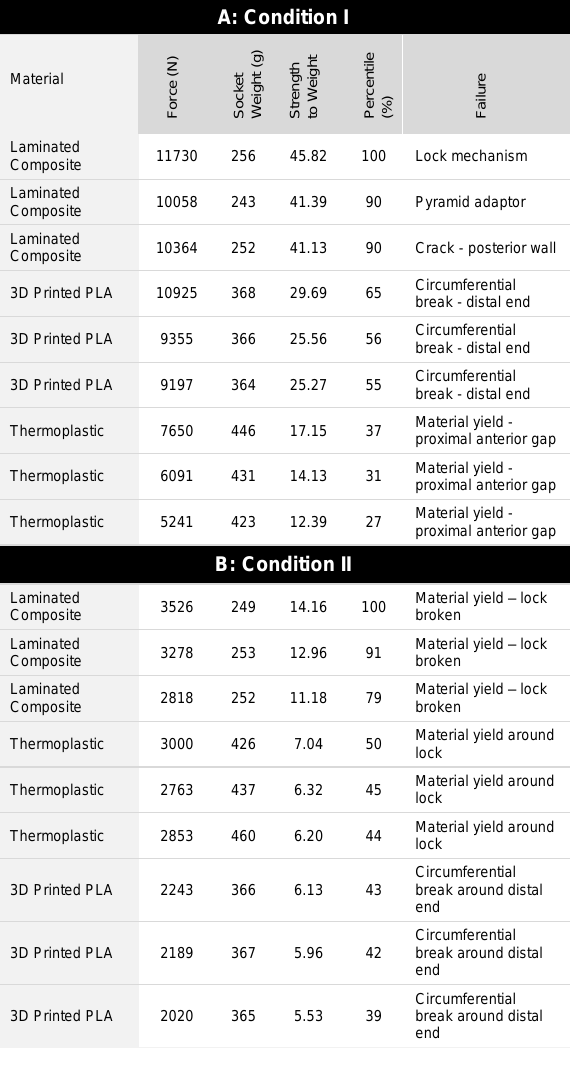
TABLE 5. A: Strength to weight ration of locking sockets at Condition I; B: Strength to weight ration of locking sockets at Condition